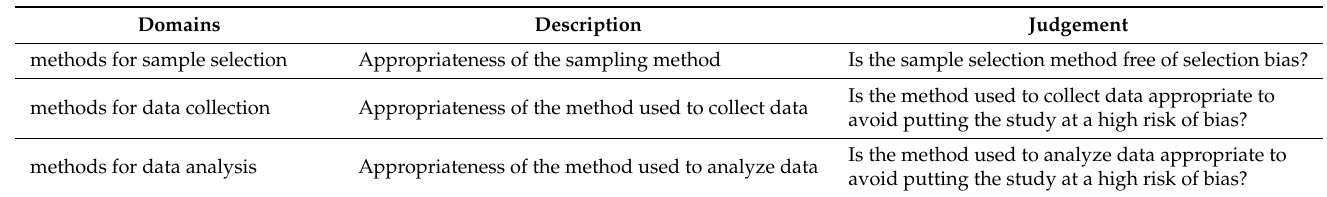
Table A3. Domains of risk of bias